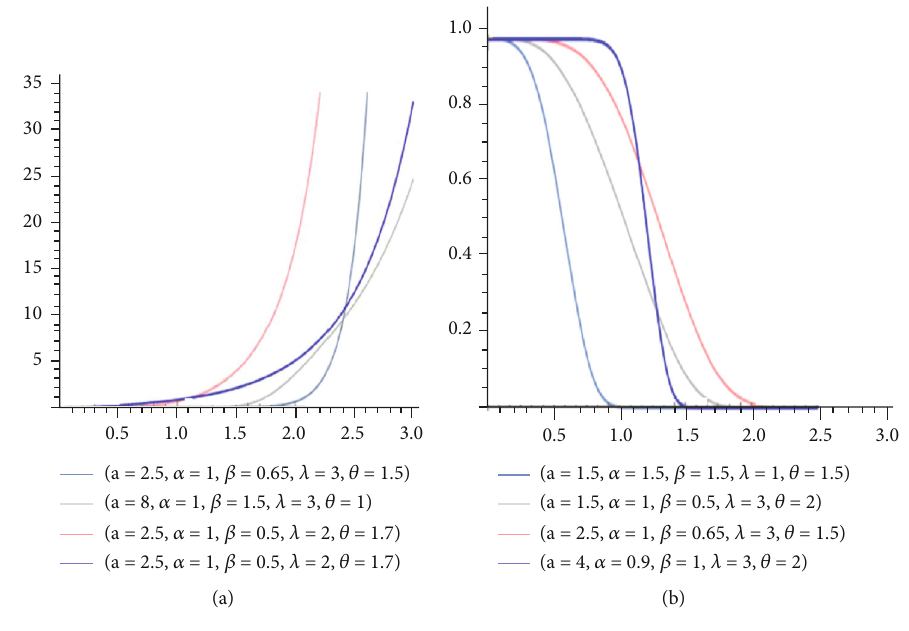
Figure 2: Plots of (a) HAZRF and (b) SURF with di ff erent values of a , α , β , λ , and θ